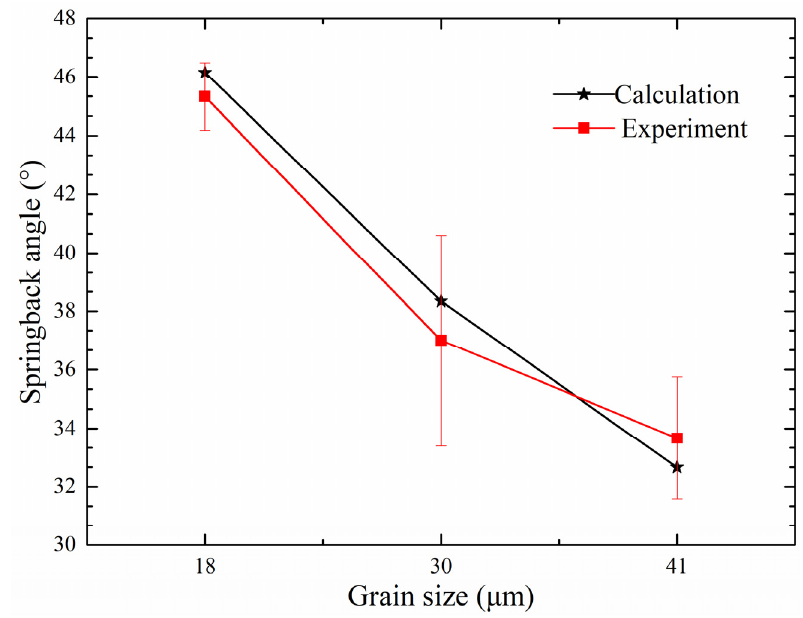
Figure 11. Springback angle of the bending specimen with a thickness of 0.1 mm.